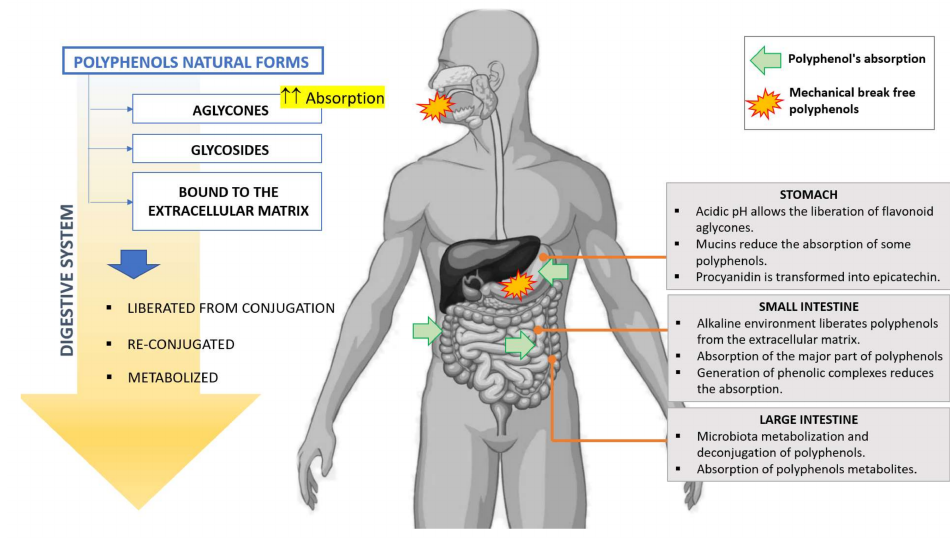
Figure 2. Absorption and metabolism of